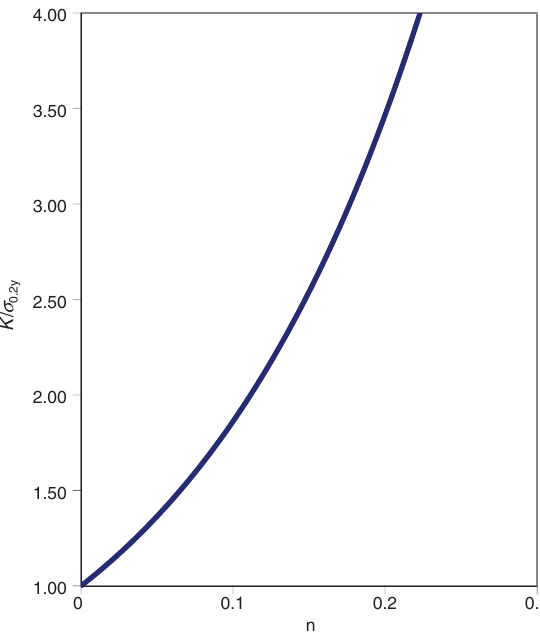
Figure 4 Comparison of present methodology with ASTM E-646 for: (A) strain hardening exponent and (B) strength co-efficient for aeroengine materials data from MMPDS